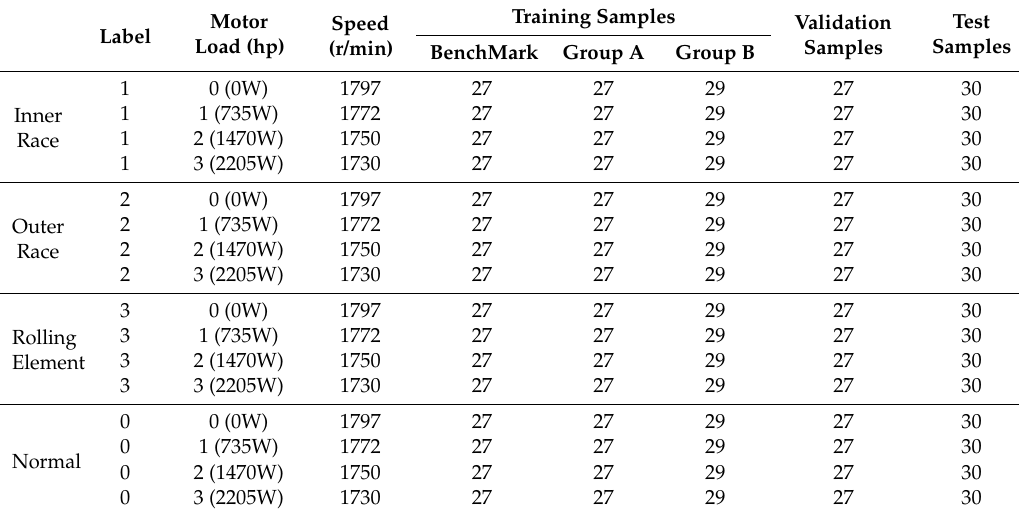
Table 1. The number of